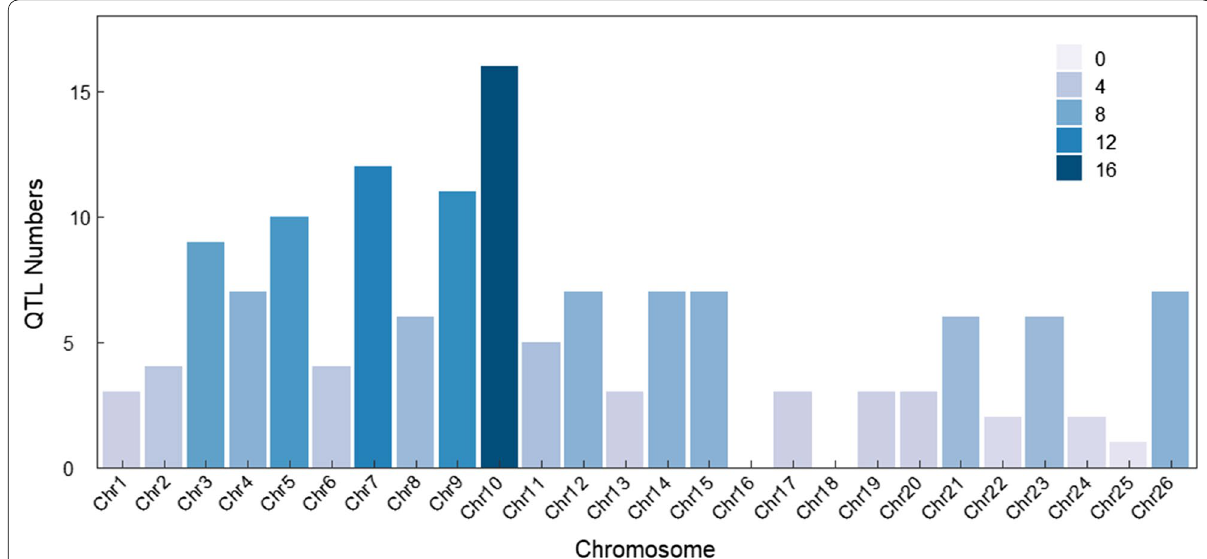
Fig. 1 Distribution of cotton Verticillium wilt resistance-related QTLs on 26 pairs of